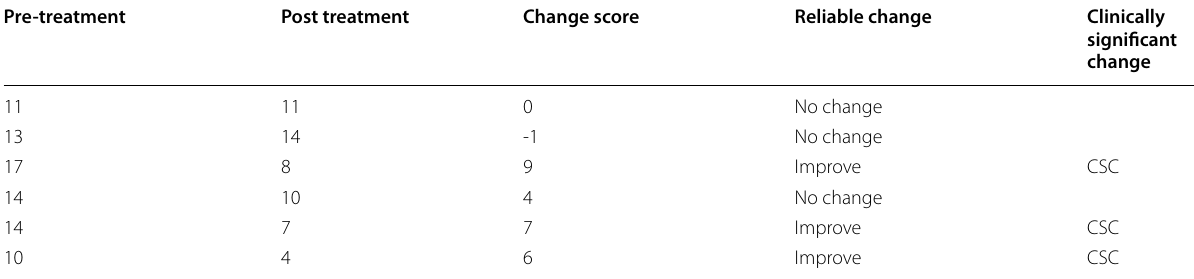
Table 3 Reliable improvement and clinically significant change in HADS Depression, per participant